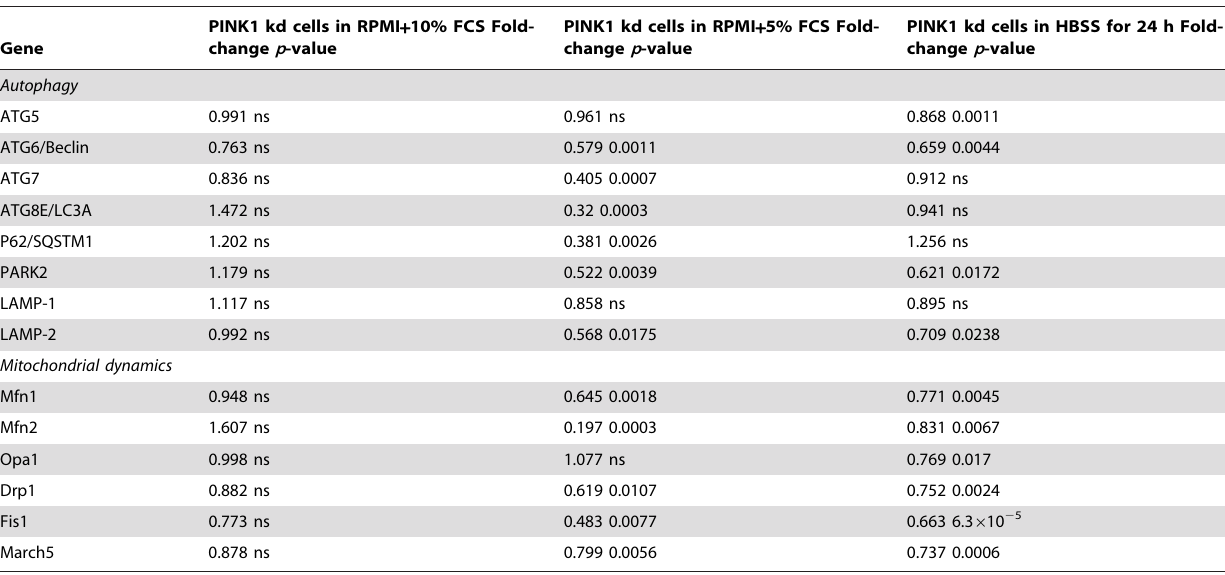
Table 1. Reduced expression of autophagy genes after stable knockdown of PINK1.